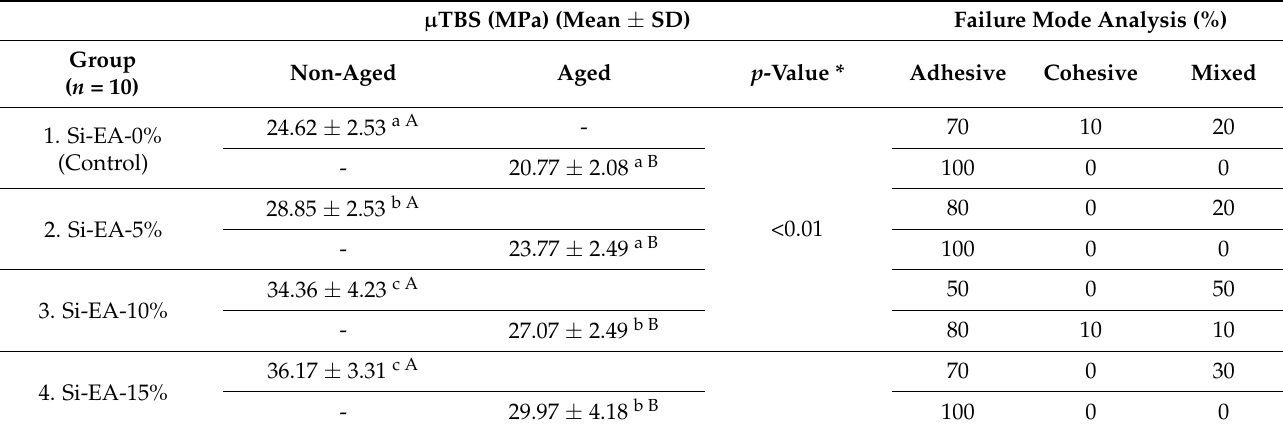
Table 1. Mean and SD of shear bond strength (SBS) and failure modes among the tested study groups.